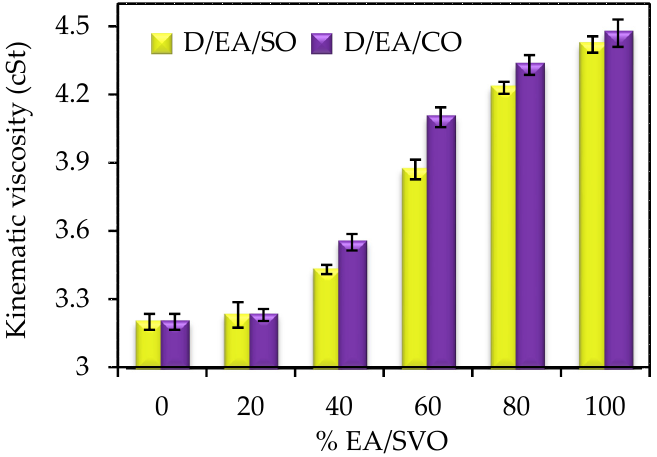
Figure 3. Kinematic viscosity values at 40 °C of diesel/ethyl acetate/sunflower oil (D/EA/SO) and diesel/ethyl acetate/castor oil (D/EA/CO) triple blends. The results are the average of three measurements and errors are represented as standard deviation through error bars.